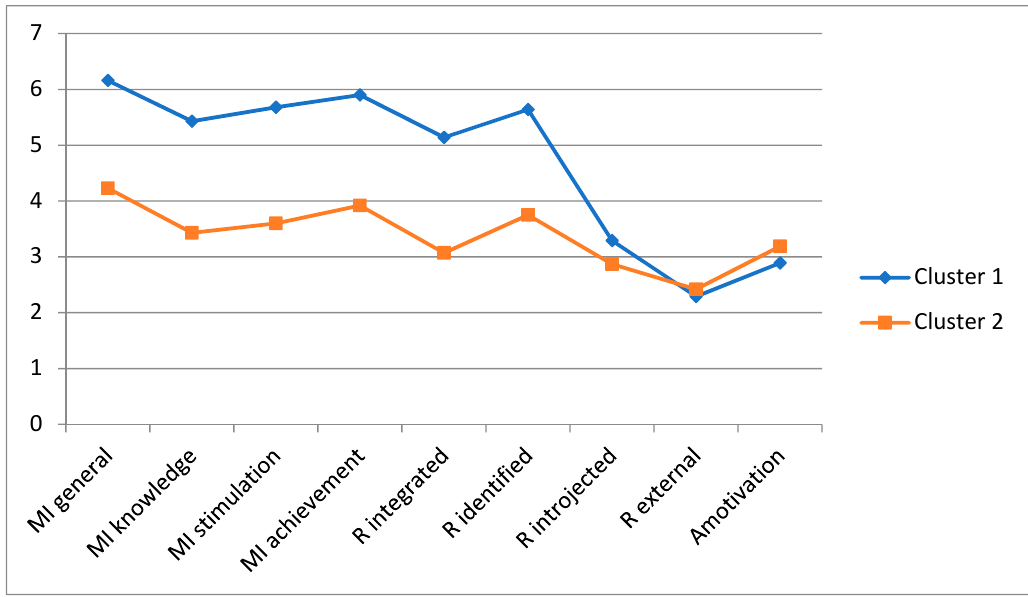
Figure 1. Analysis of Hierarchical Conglomerates with Ward Method in Sample 1. Note: MI = Intrinsic motivation; R = Regulation; Cluster 1 = Self-Determined; Cluster 2 = Less Self-Determined.